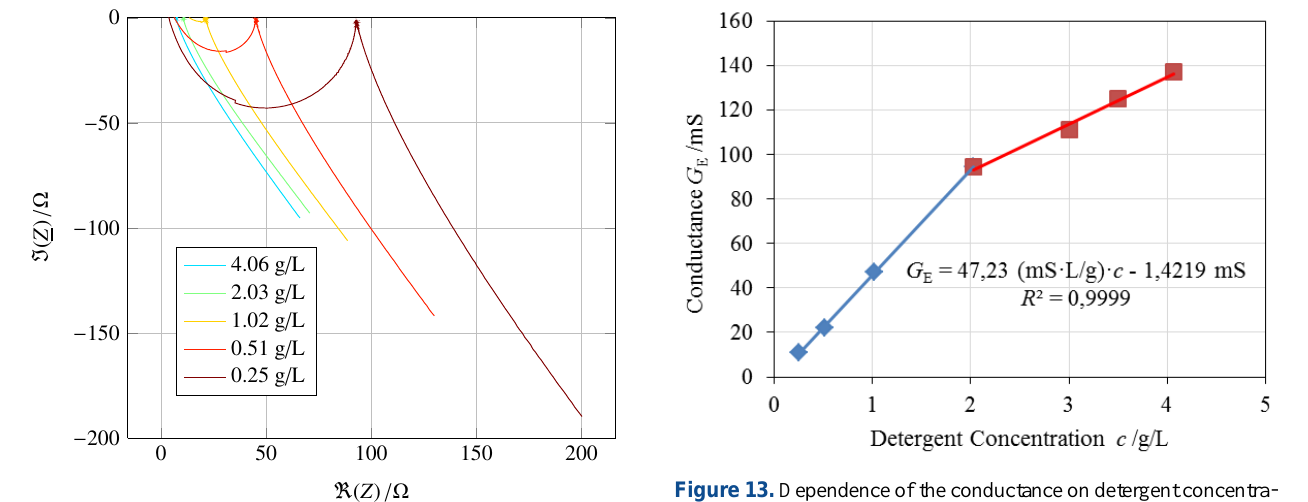
Figure 13. Dependence of the conductance on detergent concentra-